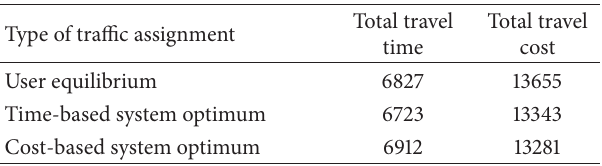
Table2:Totaltraveltimesandtotaltravelcostsunderdifferenttypes of traffic